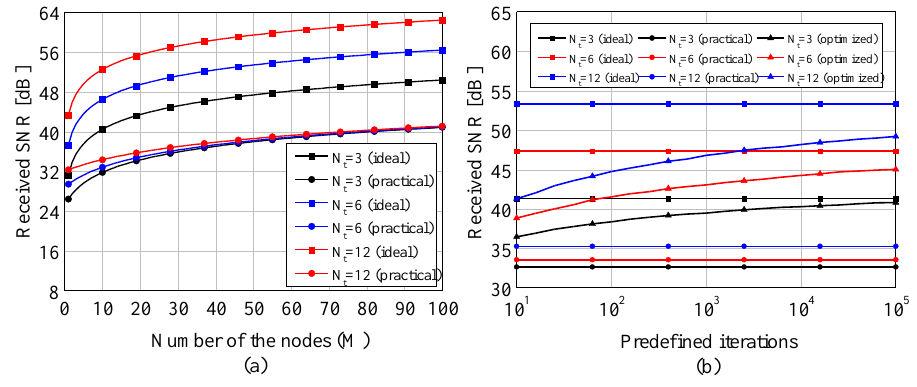
Figure 6. ( a ) The received SNRs. Here, the difference between the terms of “ideal” and “practical” is whether ∀ m ∈ M has Ω m = 0 or not. ( b ) The simulated SNRs of the proposed algorithm versus the predefined iterations. The constraints of ζ and ν are not applied